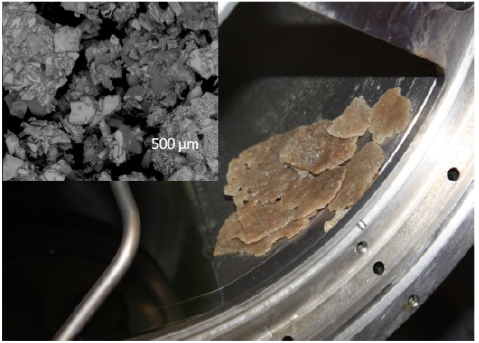
Figure 3. Photograph of calcium sulfate precipitates formed inside the Urine Processor Assembly (UPA) distillation assembly on the International Space Station (ISS), and scanning electron micrograph (inset) of precipitates formed during UPA ground tests. Photo and micrograph courtesy of the NASA Marshall Space Flight Center Environmental Control and Life Support (ECLS) Project.